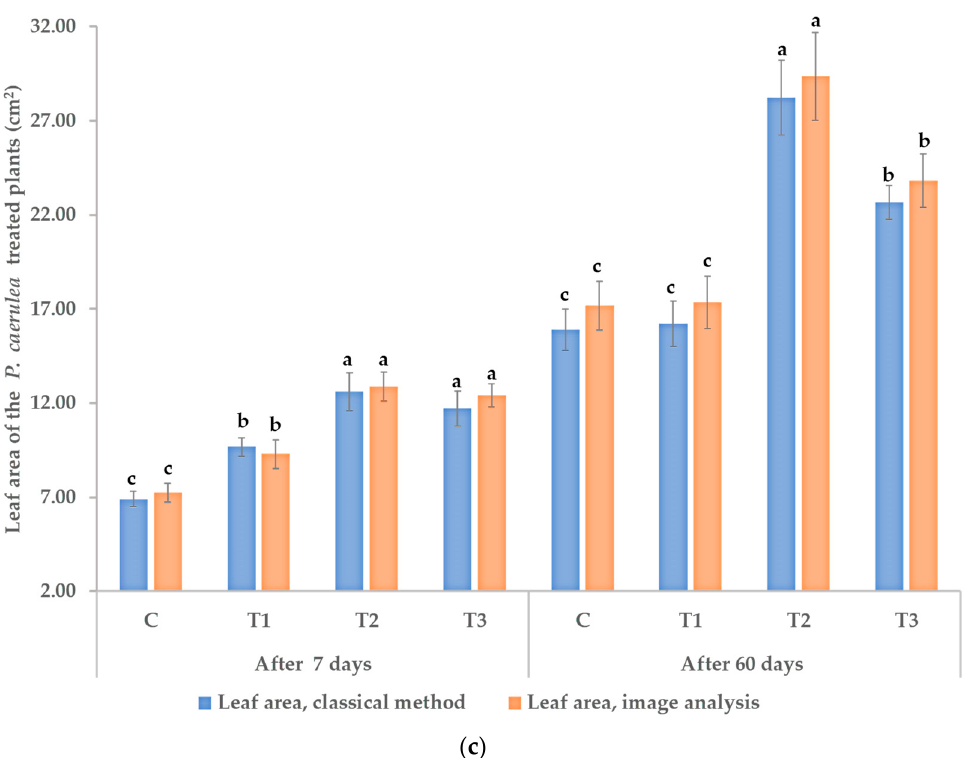
Figure 1 . Effect of foliar treatment with plant biostimulants on the development of the leaves of P. caerulea plants after seven days from the first treatment and after 60 days from the first treatment: ( a ) effect on the leaf length (average of 10 leaves per replicate, four replicates per each treatment); ( b ) effect on the leaf width (average of 10 leaves per replicate, four replicates per each treatment); ( c ) effect on the average leaf area (cm 2 , average of 10 leaves per replicate, four replicates per each treatment). C—control (no treatment with plant biostimulants, treated only with water); T 1 —foliar treatment with Trichoderma consortium suspension, 10 6 cfu / mL, equiv. to 10 11 spores / ha; T 2 —foliar treatment with Trichoderma consortium suspension, 10 8 cfu / mL, equiv. to 10 13 spores / ha; T 3 —foliar treatment with a reference product, consisting of plant extracts, essential oils, and fatty acids in an oil / water emulsion and extract of the seaweed Ascophyllum nodosum , equiv. to 3 L / ha. The values presented represent means ± standard errors ( n = 40 plants). Columns that are labeled with di ff erent letters, compared between the di ff erent treatments (C, T1, T2, and T3) within each parameter and time period (after 7 days and, respectively, after 60 days) are significantly di ff erent at p < 0.05.